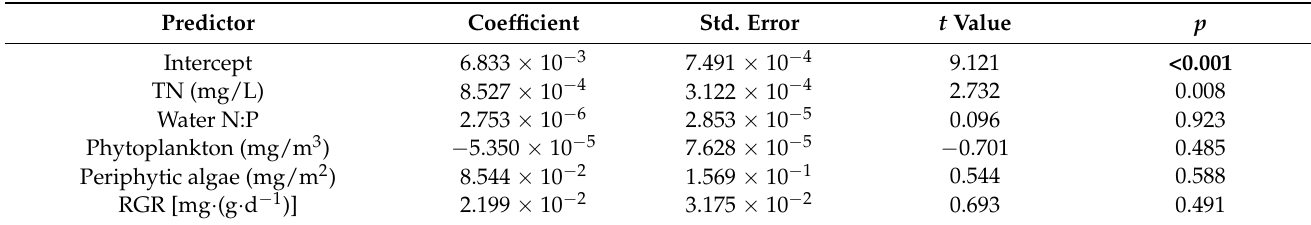
Table 3. Summary of the best model of the relationship between H. verticillata N and water